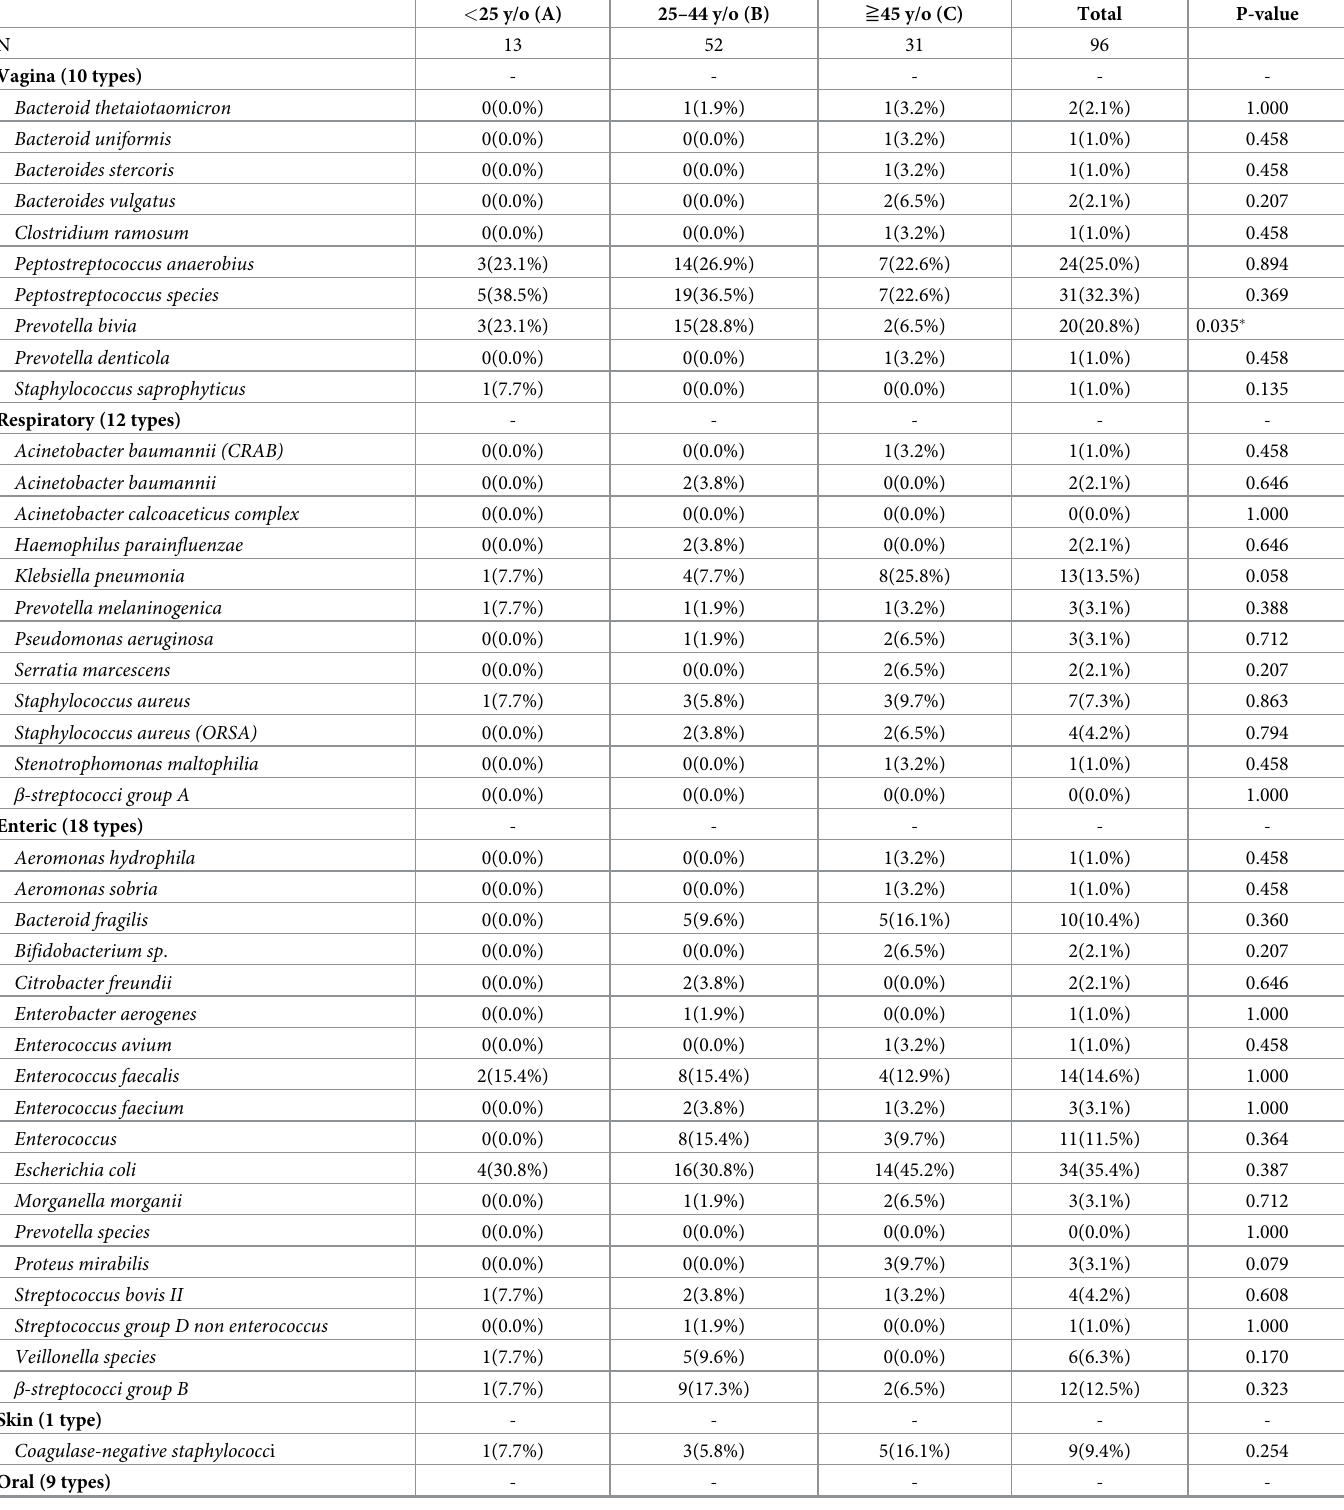
Table 3. The numbers (percentage) of different categorial pathogens in pelvic inflammatory disease patients (n =